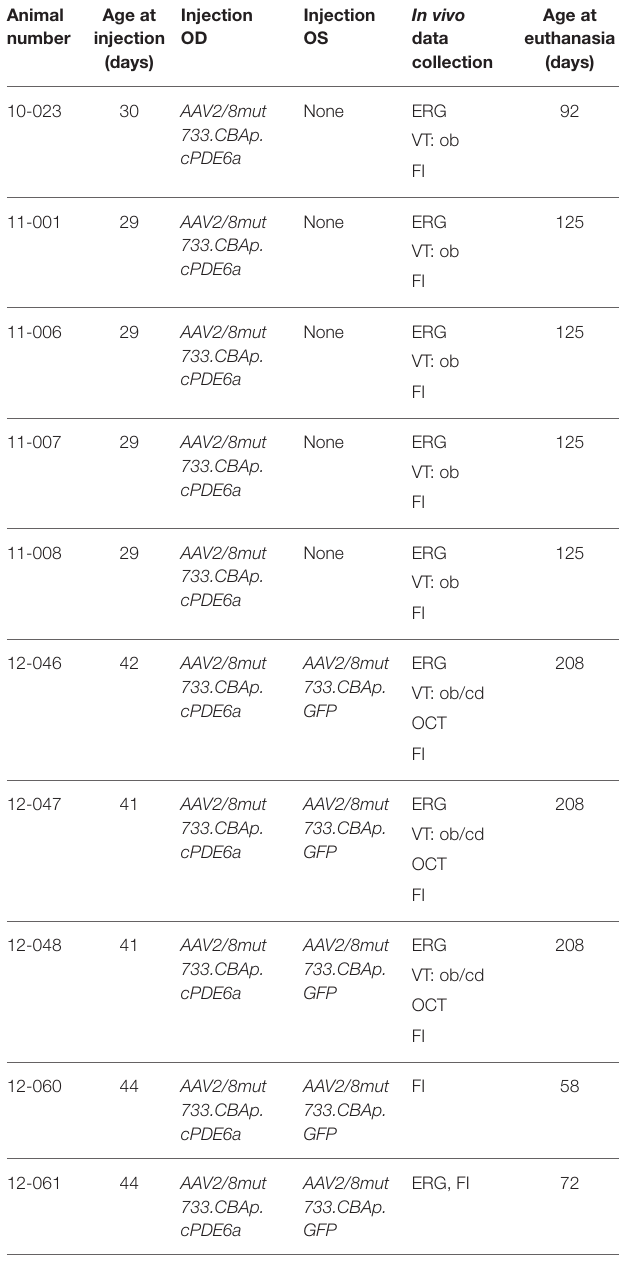
TABLE 1 | Details of dogs used for experimental